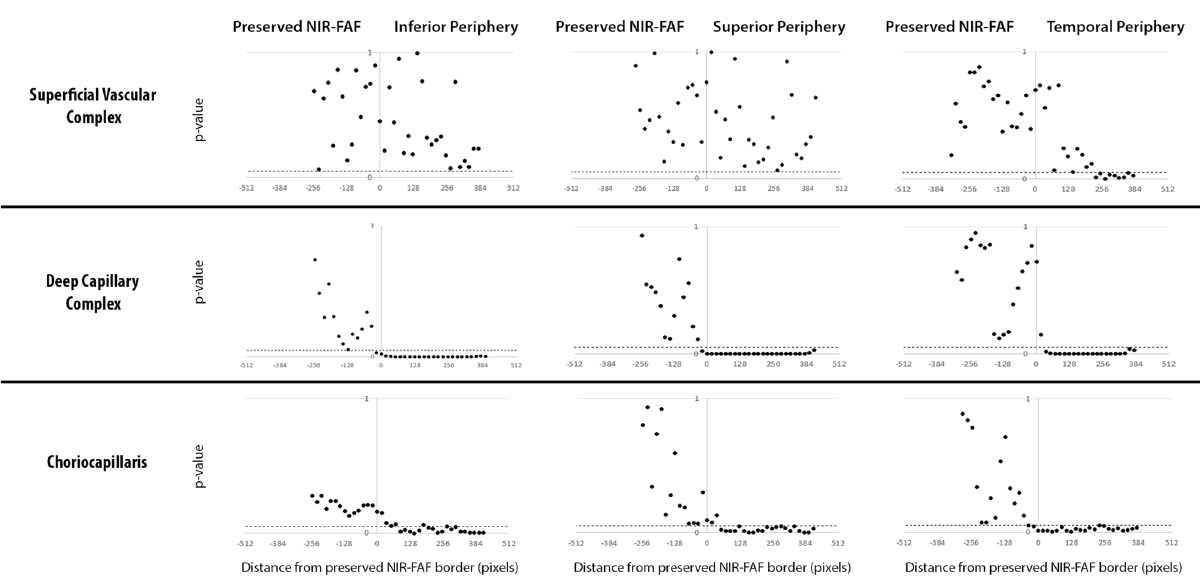
Figure 8. P-values obtained for each analyzed sample area from the comparison between patients with retinitis pigmentosa and age-matched controls. A Wilcoxon signed-rank test was performed to obtain each p-value. The black dotted line corresponds to the threshold of significance considered in the study (p < 0.05). The “0” on the x-axis corresponds to the border of the preserved near infrared fundus autofluorescence